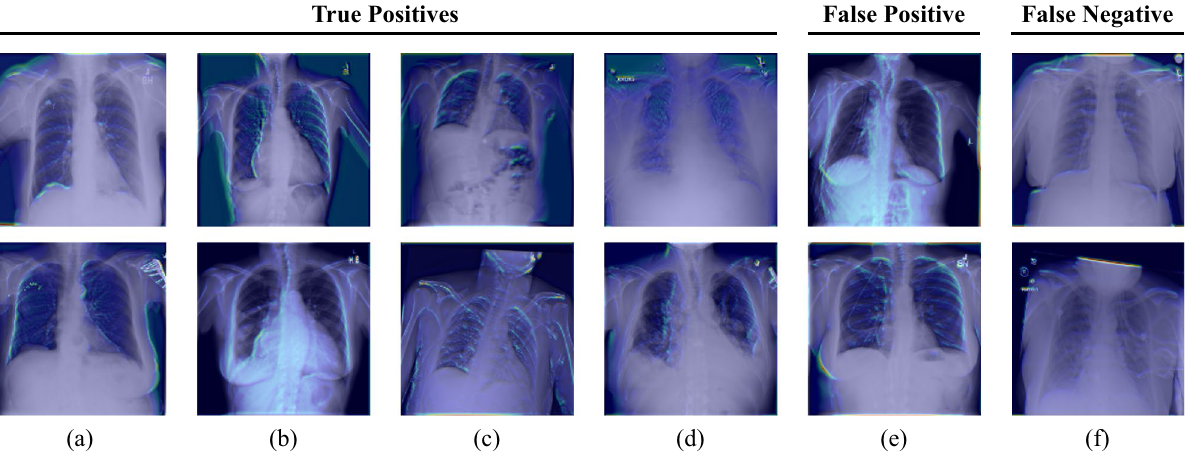
Figure 6. Grad-CAM visualizations for the first convolutional layer of the ResNet-50 incorporated in our SNN. Each column represents one image pair. The first four columns ( a – d ) show true positive classifications. The last two columns ( e ) and ( f ) depict a false positive and a false negative classification, respectively. The shown images illustrate that the anatomical structure of, e.g. the breast (cf. ( a , b , e )), the lungs (cf. ( a , b , c , e )), and the heart (cf. ( a , b )) have a high impact on the final model prediction. Furthermore, it can be seen that our network focuses on the collarbones (cf. ( a , c , d , f )) and the ribs (cf. ( b , c , e )). The upper images of ( a ) and ( f ) also highlight that our network pays attention to the contour of the diaphragm.